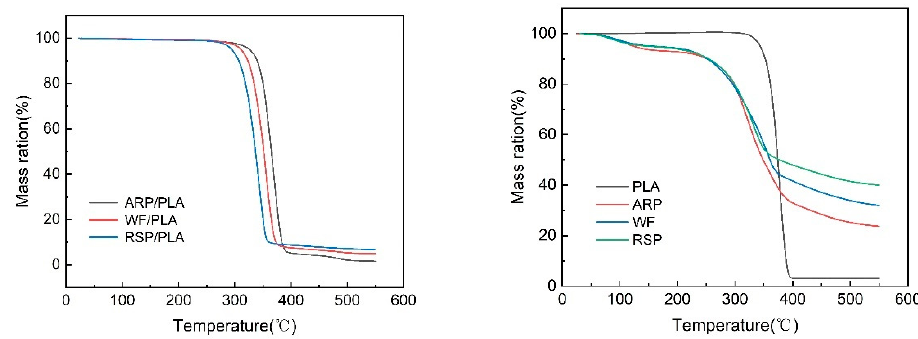
( d ) Figure 4. Micro morphologies of PLA and different plant fiber/PLA biocomposite specimens: ( a )